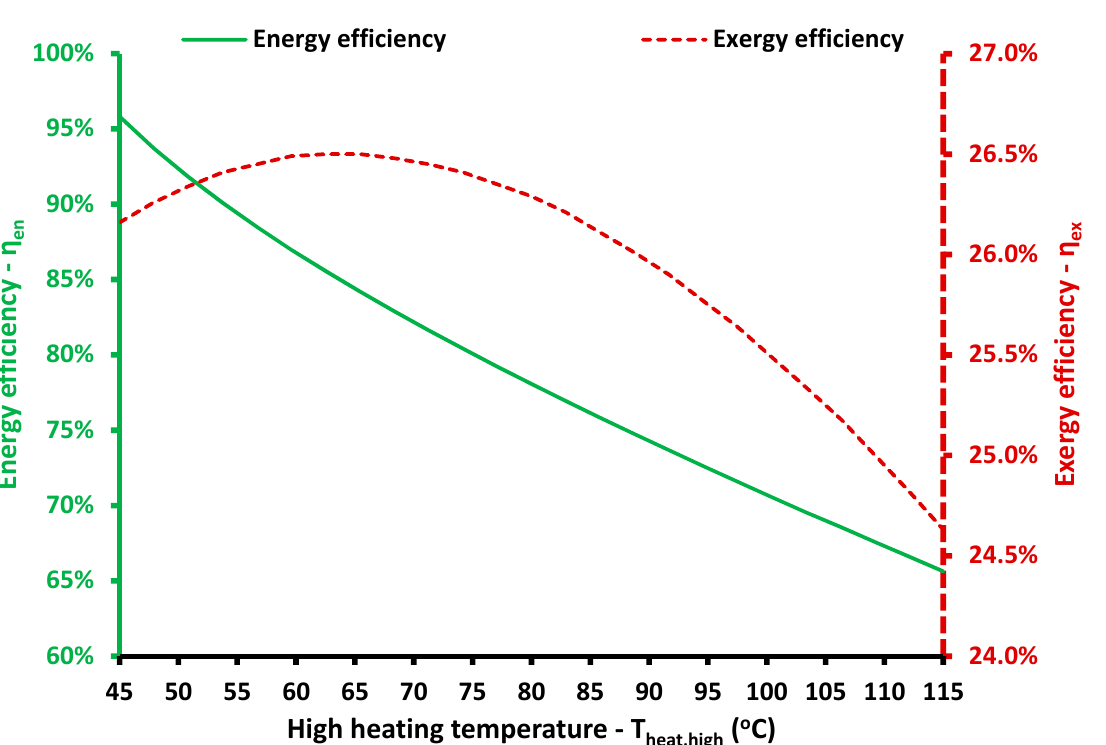
Figure 17. Energy and exergy efficiencies for different values of the high heating temperature. Table 4. The impact of the examined parameters on the energy and exergy efficiencies.